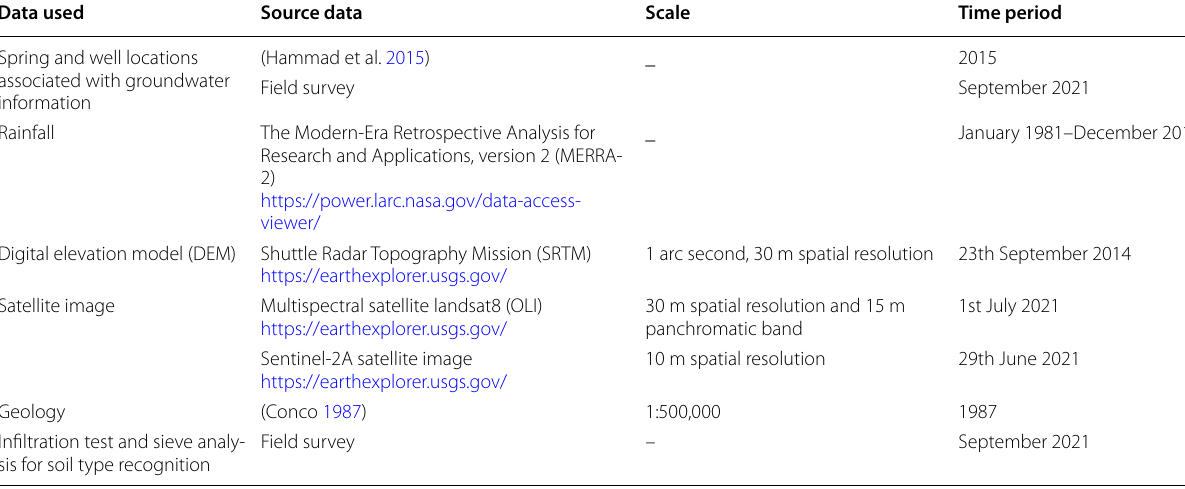
Table 1 Data used for effective features creation and dependent feature